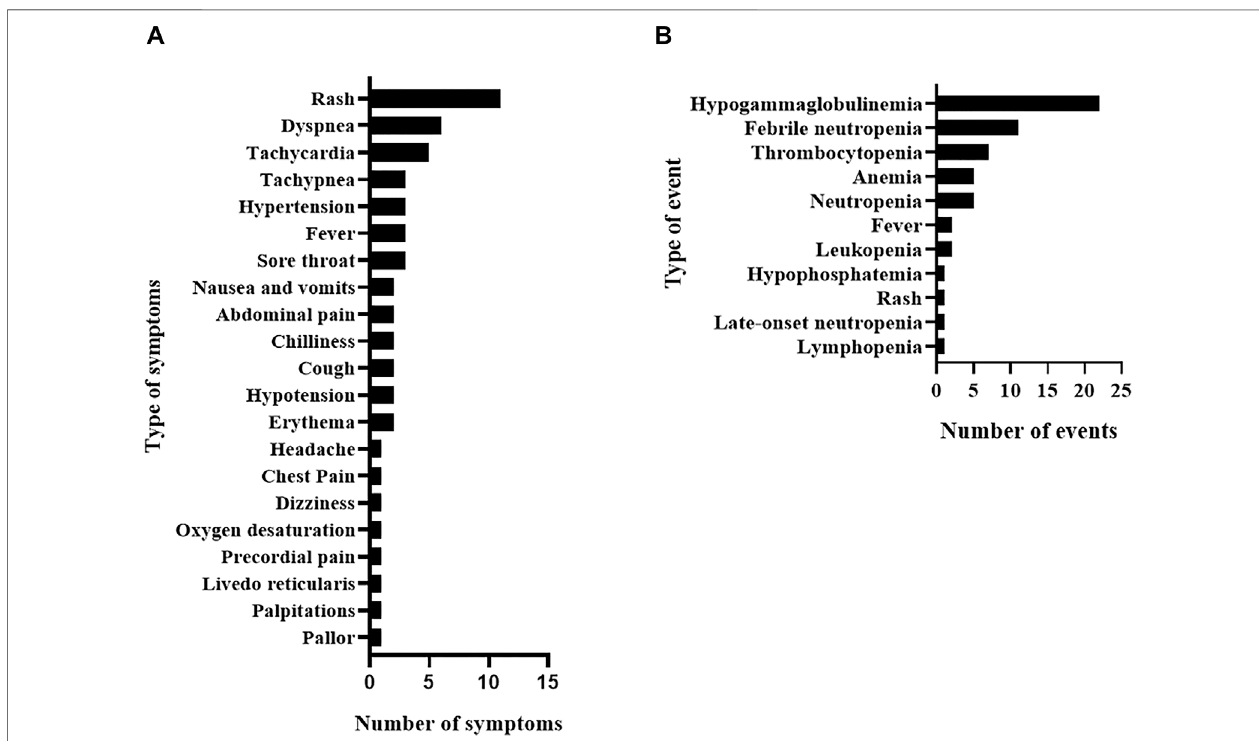
FIGURE1| Rituximabadversedrugreactionsinthe studypopulationincluding infusion-related reactions and their associatedsymptoms (A) and delayed adverse drug reactions (B) .